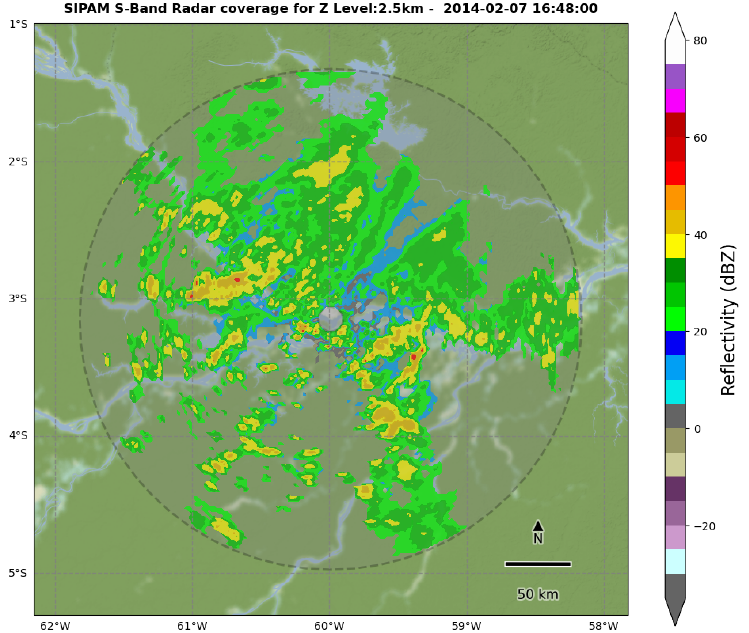
Figure 1. Study area and coverage of the S-Band Radar SIPAM. The contours of the image refer to the radar reflectivities at 2.5 km height at 16:48:00 GMT of 7 February